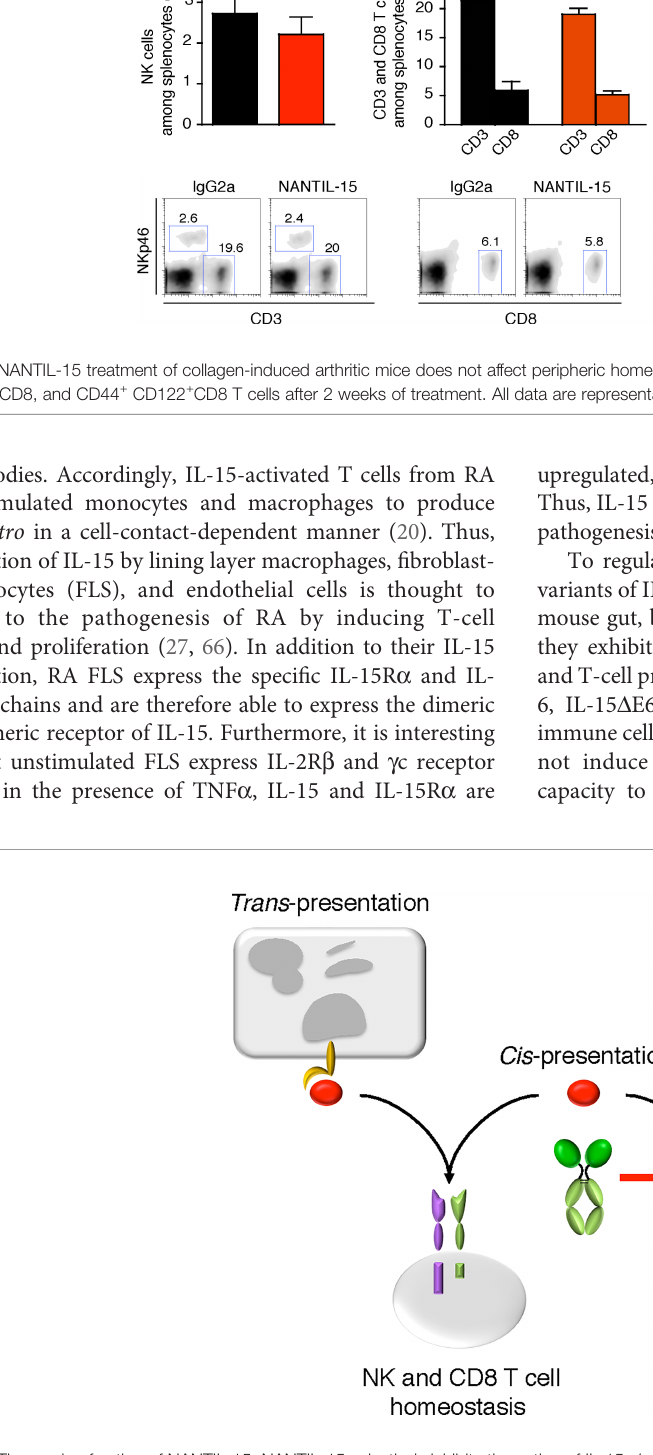
FIGURE 7 | The mode of action of NANTIL-15. NANTIL-15 selectively inhibits the action of IL-15 via the trimeric IL-15R a /IL-2R b / g c receptor, leaving its action via the dimeric IL-2R b / g c receptor or in trans -presentation intact. By reducing the clinical signs of in fl ammation without any impact on NK and CD8 T cells homeostasis, the action of NANTIL-15 indicates that IL-15-induced in fl ammation acts through the trimeric IL-15R a /IL-2R b / g c